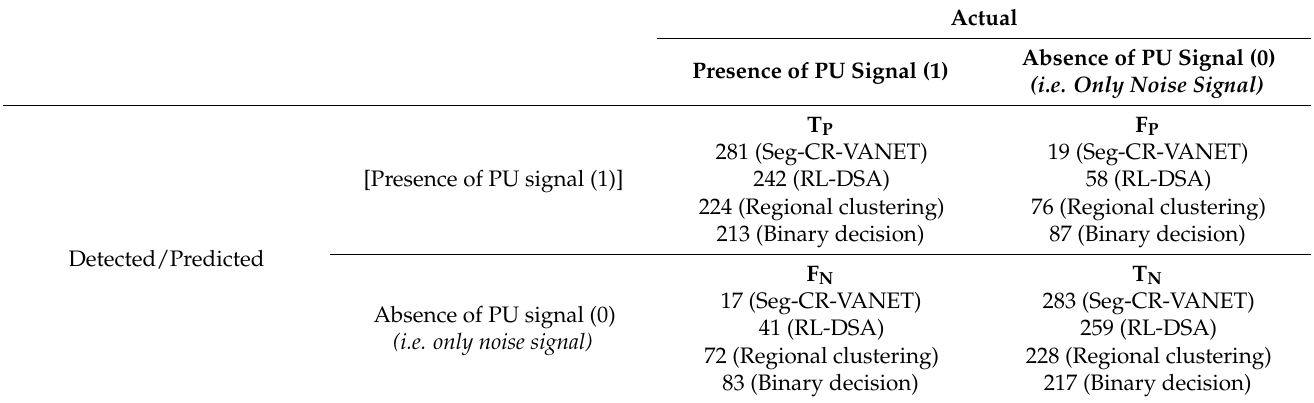
Table 8. Confusion matrix.